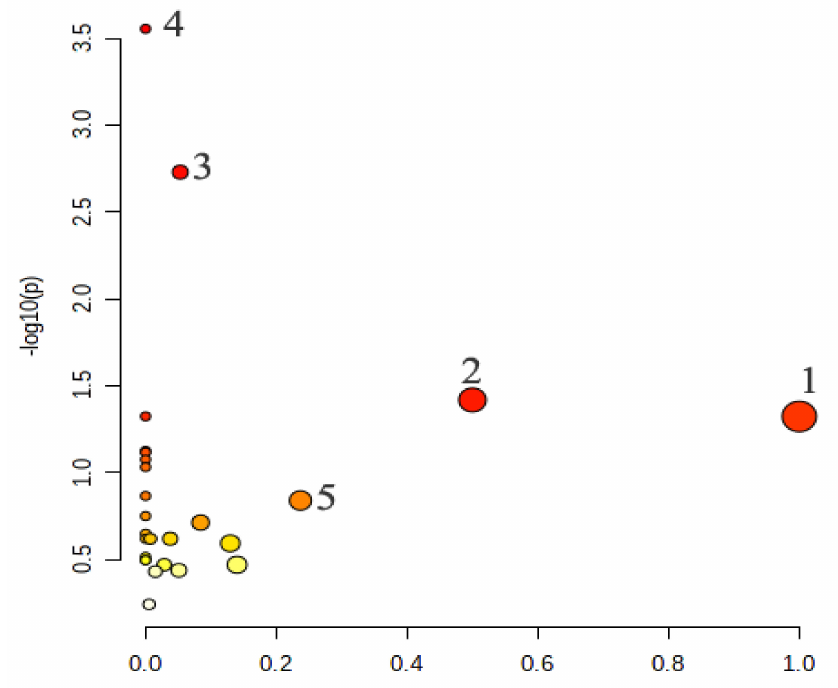
Figure 8. Metabolic pathway analysis. 1: Linoleic acid metabolism. 2: Phenylalanine, tyrosine and tryptophan biosynthesis. 3: Galactose metabolism. 4: Biosynthesis of unsaturated fatty acids. 5: Glycerolipid